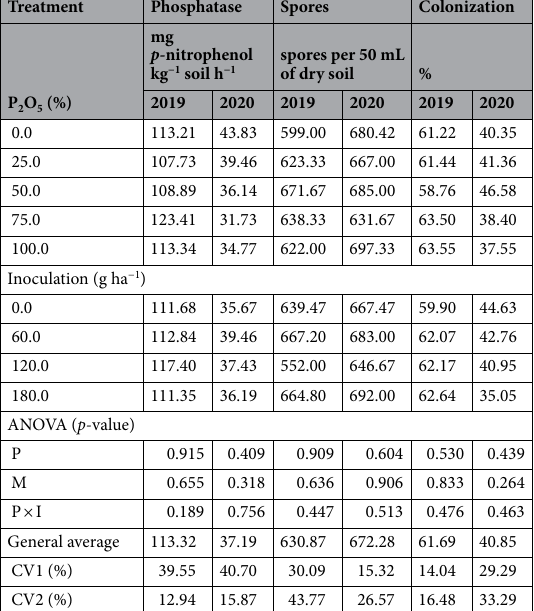
Table 1. Acid phosphatase activity (PHOSPHATASE), number of spores of arbuscular mycorrhizal fungi in the soil (SPORES), and percentage of mycorrhizal colonization of maize roots (COLONIZATION) as a function of applied amounts of P 2 O 5 and inoculant containing Rhizophagus intraradices . CV: coefficient of variation